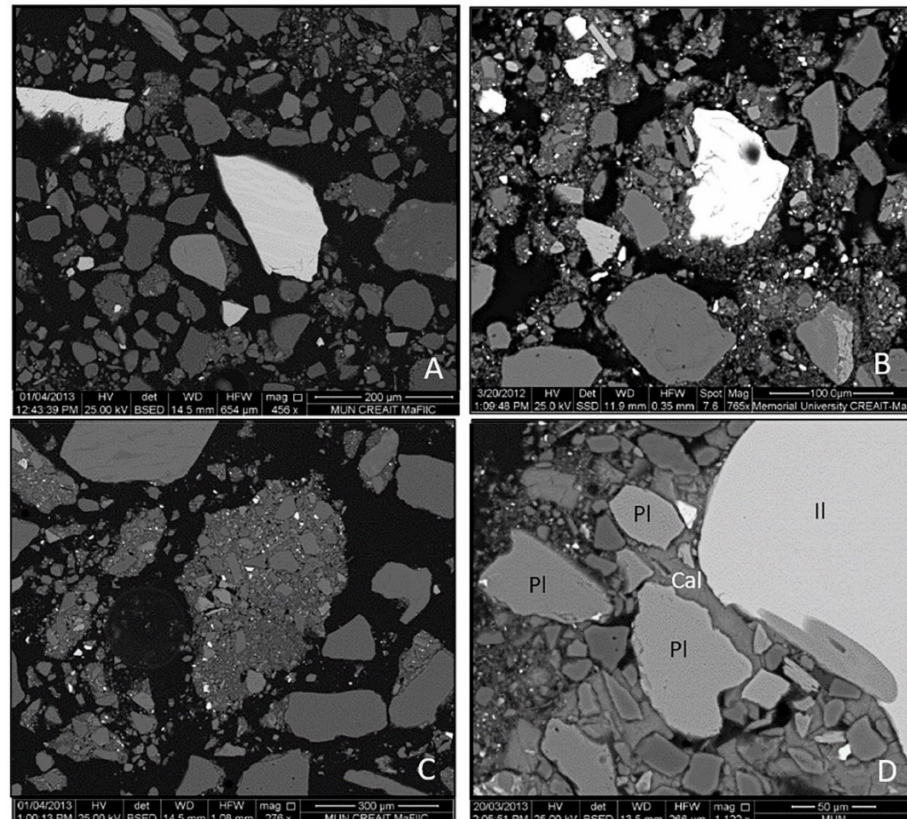
Figure 9. BSE images of polished grain mounts of clay cover of the Ovoid deposit: ( A ) Po grain with exsolved troilite (sample OV11-CL001), ( B ) large Ccp grain (bright) (sample OV11-CL003), ( C ) minute Po and Pn grains (white) in clay cover material (sample OV11-CL003), and ( D ) Ilmenite (Il) and plagioclase grains (Pl) cemented by calcite (Cal) (sample